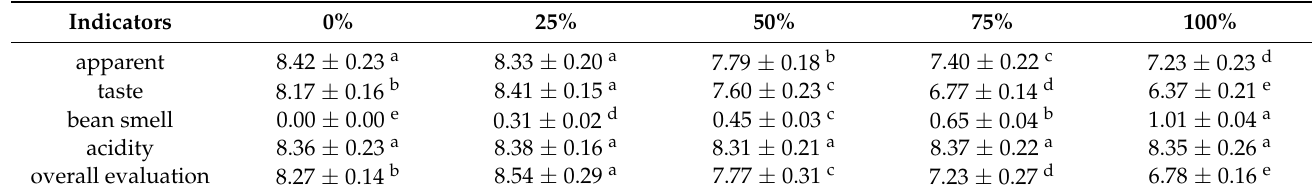
Table 3. Sensory evaluation of yogurt with different substitution